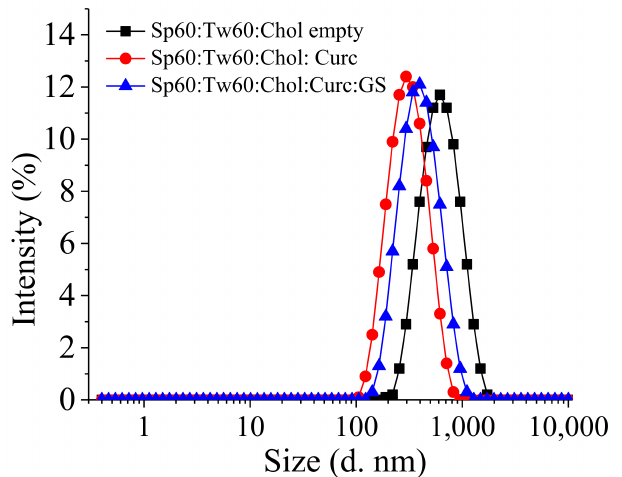
Figure 1. Size distribution of Tw60:Sp60:Chol either empty or simultaneously loaded with Curc and GS. Total lipid ratio is 30 µ mol/mL, where Tw60:Sp60:Chol (3.5:3.5:3